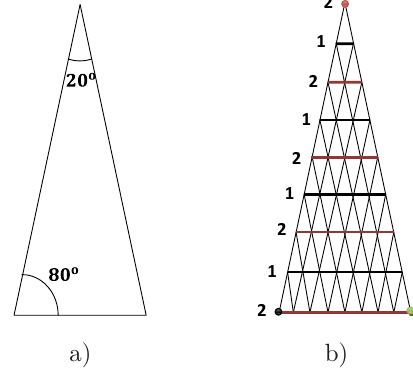
Figure 5. Isosceles triangle with common angle 80 o , and zebra-type smoother corresponding to the smallest angle of the